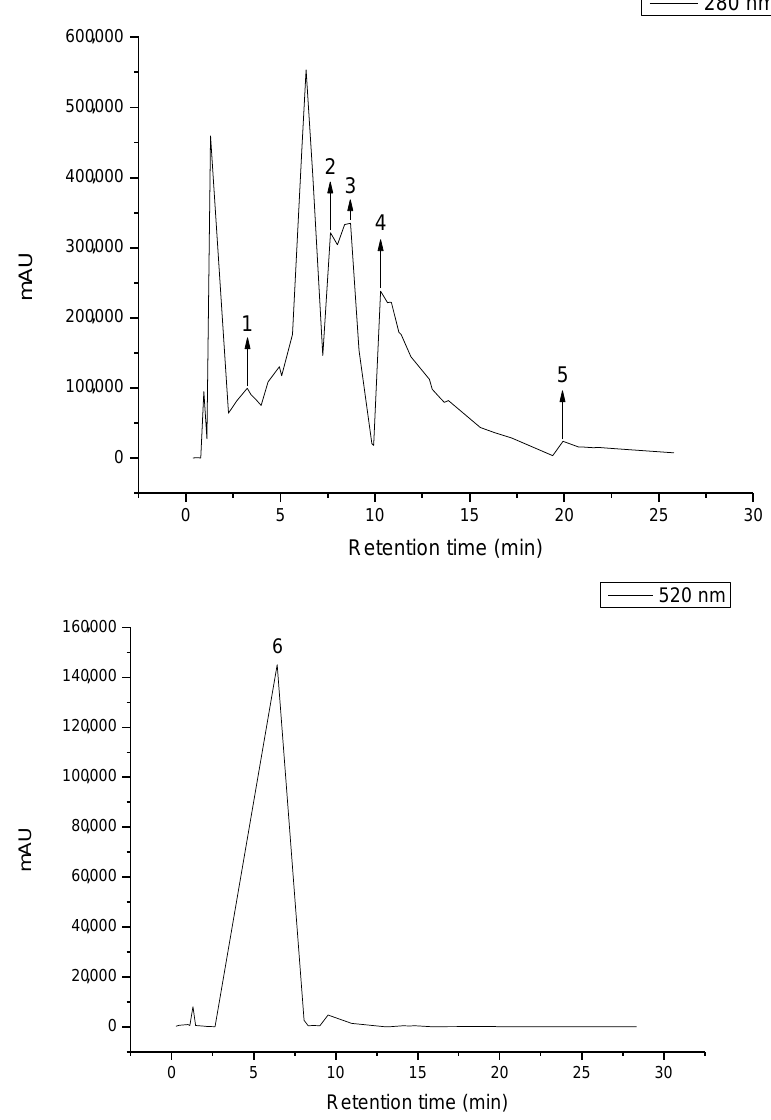
Figure 2. HPLC chromatograms of JPE. 1. Gallic acid, 2. Caffeic acid, 3. p-Coumaric acid, 4. trans-Ferulic acid, 5. Kaempferol, 6. Cyanidin-3-glucoside.